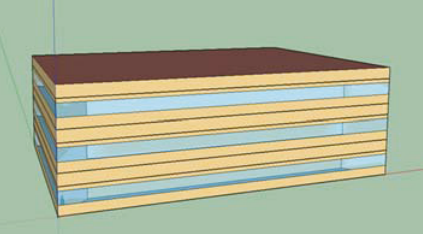
Figure 1: Building structure simulated in EnergyPlus software.